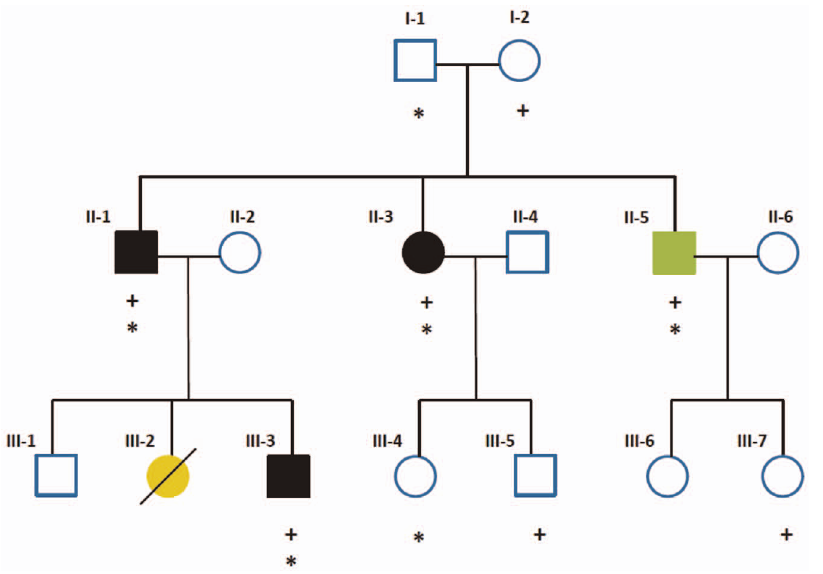
Figure 1. Pedigree of the three-generation family included in this study. Slash: deceased. Solid black: individuals affected with HSCR only. Green: individual affected with HSCR and heterochromia iridum. Yellow: individual affected with HSCR and meningocele. + indicates EDNRB c.1A . G; * indicates EDN3 c.-248G . A.